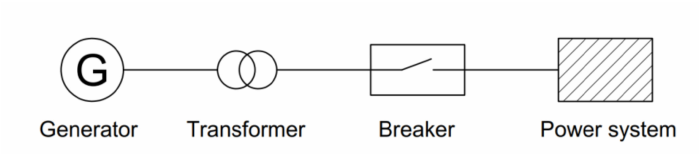
Figure 5. Single-line diagram of simulated case.